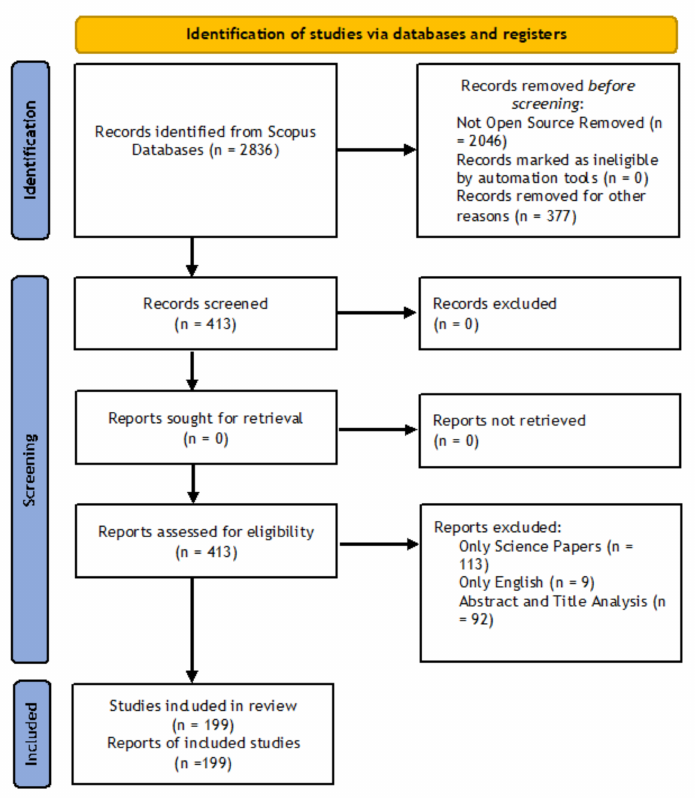
Figure 2. Identification of Studies Via Scopus